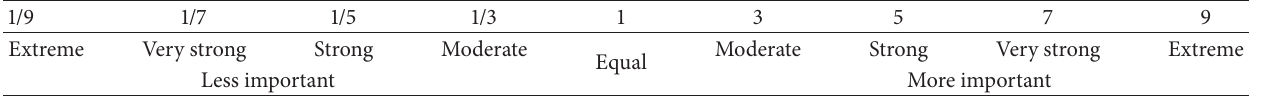
Table 2: Rating for pairwise comparison [7, 25].